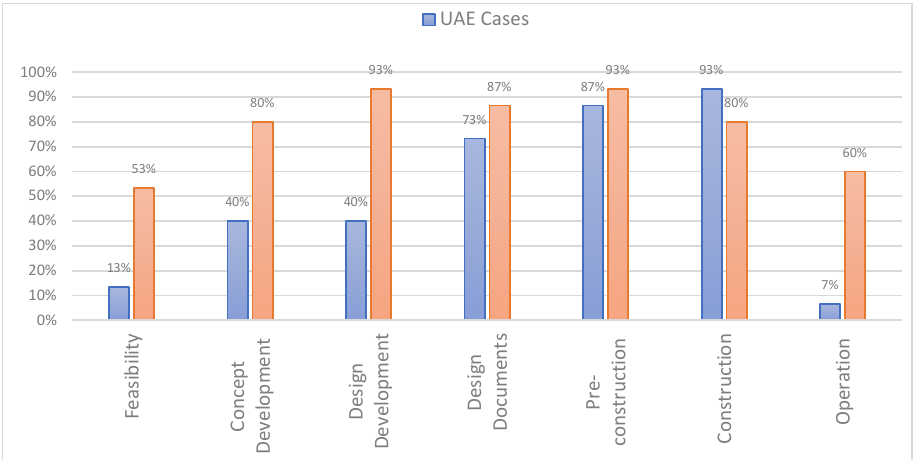
Figure 1. Extent Participant (Parties and Teams) Involvement.